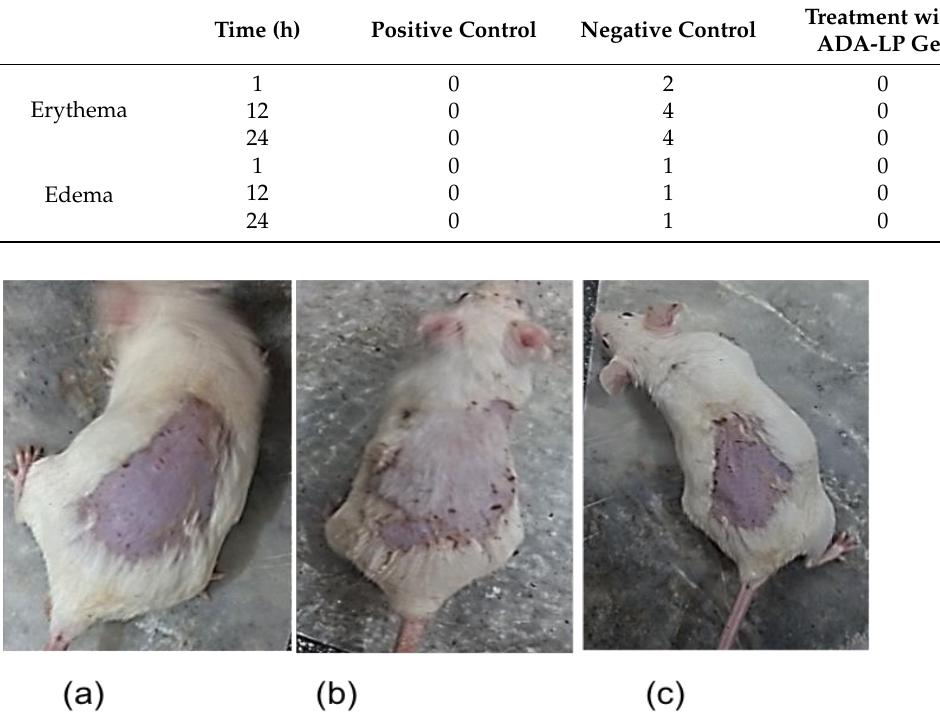
Table 4. Skin irritation study according to Draize scoring system.